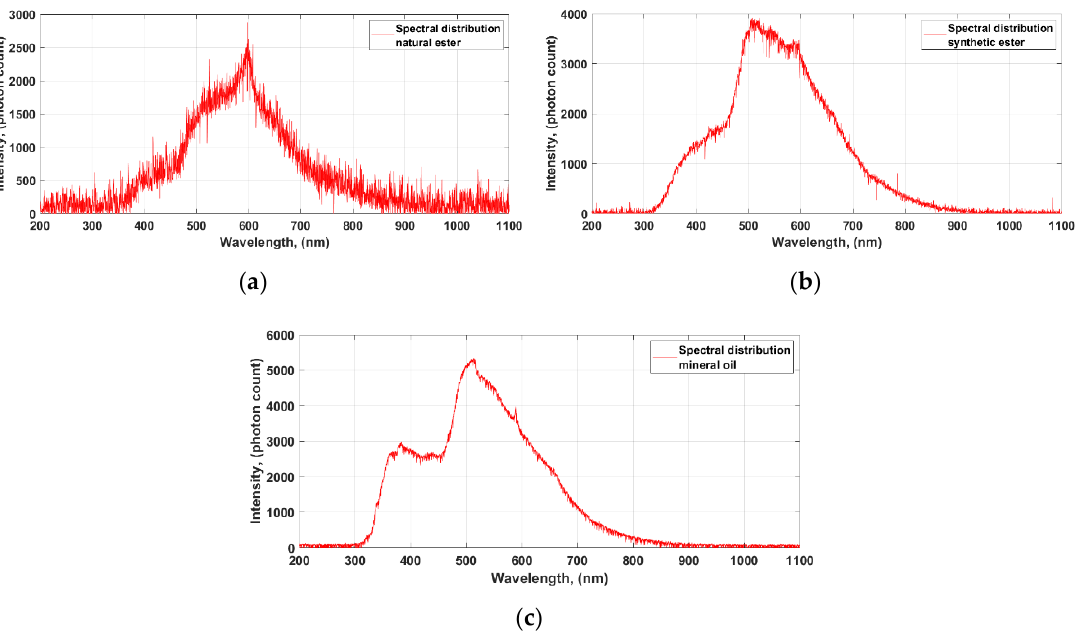
Figure 5. Example results of measurements generated on a surface discharge system at 35 kV supply voltage for the following insulating liquids: Midel 1204 ( a ); Midel 7131 ( b ); and Mineral oil ( c ).